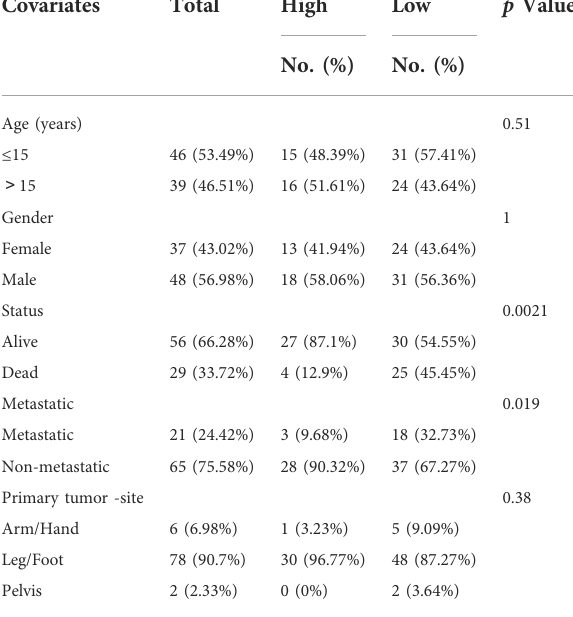
TABLE 1 Relationship between cuproptosis score and clinicopathological features of OS in TARGET.